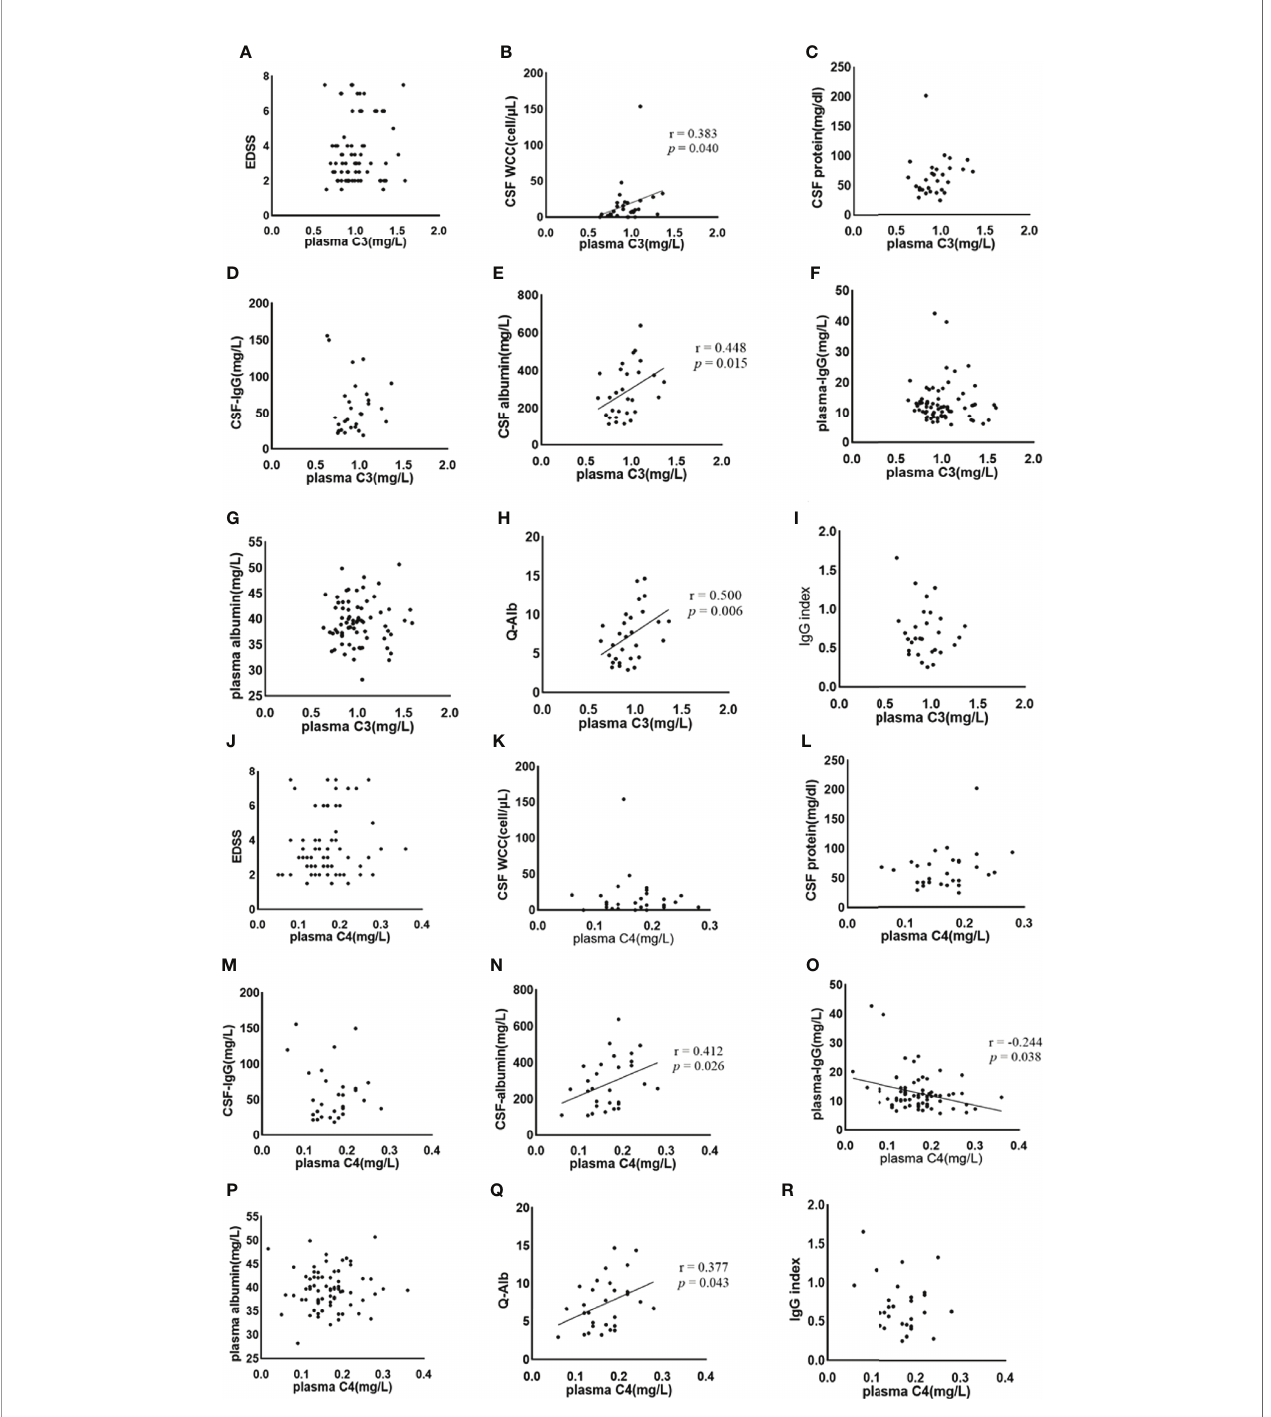
FIGURE 3 | The association between plasma C3, C4 and NMOSD features was analysed by Spearman ’ s correlation. C3, complement 3; C4, complement 4; EDSS, Expanded Disability Status Scale; CSF, cerebrospinal fl uid; WCC, white cell count; IgG: immunoglobulin-G; Q-Alb, CSF/plasma albumin ratio. The (A – I) shows the Spearman results of serum complement C3 and EDSS (A) , CSF WCC (B) , CSF protein (C) , CSF-IgG (D) , CSF albumin (E) , plasma IgG (F) , plasma albumin (G) , Q- Alb (H) , and IgG index (I) , respectively. There is a signi fi cant association between plasma CSF WCC, CSF albumin, and Q-Alb. The (J – R) shows the Spearman results of serum complement C4 and EDSS (J) , CSF WCC (K) , CSF protein (L) , CSF-IgG (M) , CSF albumin (N) , plasma IgG (O) , plasma albumin (P) , Q-Alb (Q) , and IgG index (R) , respectively. Positive associations exist between plasma C4 and CSF albumin, and Q-Alb respectively. A negative association exists between plasma C4 and plasma